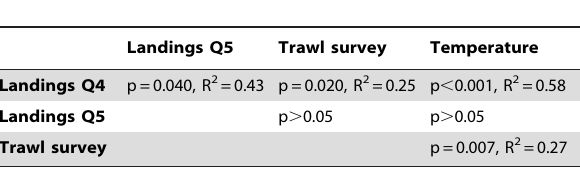
Figure S1 Temperature time series from November– January 1977–2010 northern North Sea used in the analysis of mackerel distributions (solid line as 3 year running mean). Temperature time series from February–March 1985–2010 west of Scotland (dashed line as 3 year running mean). Both series modeled as described in material and methods. Figure S2 3 year running means of temperature time series 1948–2010. Red: Primary temperature series in Novem- ber–January northern North Sea. Modeled as described in material and methods for the shorter time series. Black: Hadley